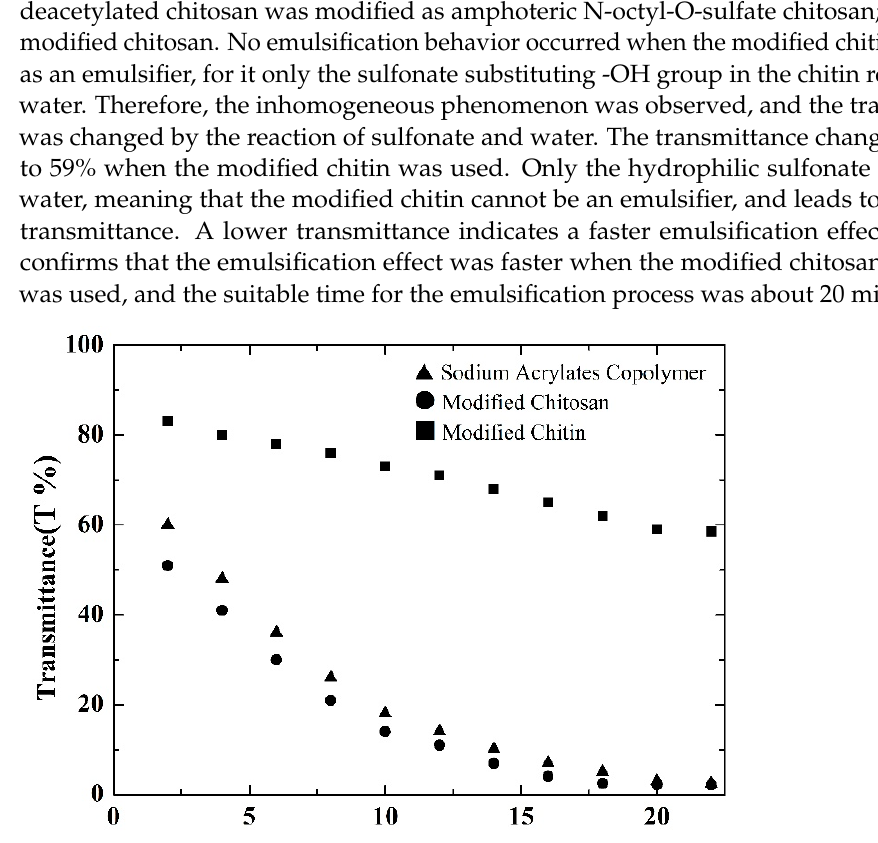
Figure 7. Comparison of numbers of bacteria for different emulsifiers. The moisture retention of the emulsion was measured with the system shown in Fig- ure 1. The spatial humidity was detected continuously after the emulsion was placed in the system. Figure 8 shows the changes in humidity over time for different emulsifiers. A lower spatial humidity indicates greater moisture retention. Since chitosan contains more hydrophilic functional groups, such as -OH and -NH, more moisture was retained in the emulsion made with chitosan. Figure 8 confirms that the moisture equilibrium time be- tween the emulsion and the gas phase was about 40 min, and the moisturizing effect of